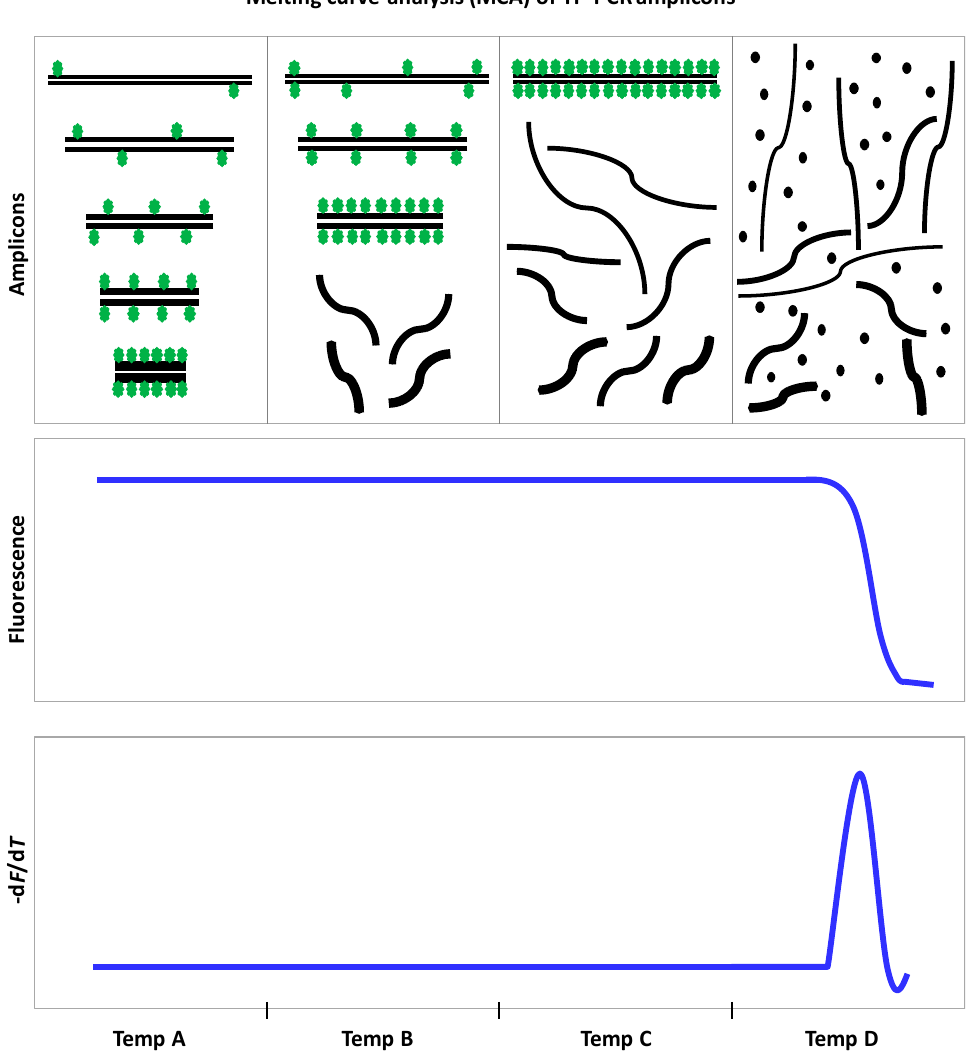
Figure 3. Melting curve analysis (MCA) of TP-PCR amplicons. Schematic illustrating how MCA of heterogeneous TP-PCR amplicons results in the generation of a single melt peak. Dissociation of double-stranded PCR products and re-distribution of SYBR Green I Dye from the shorter to larger fragments with gradually increasing temperature (Temp A to Temp C) is shown. At Temp D, when the largest amplicon strands dissociate, SYBR Green I is completely released and remains unbound to DNA, resulting in a sharp decrease in fluorescence. − d F /d T , first negative derivative of fluorescence versus temperature.